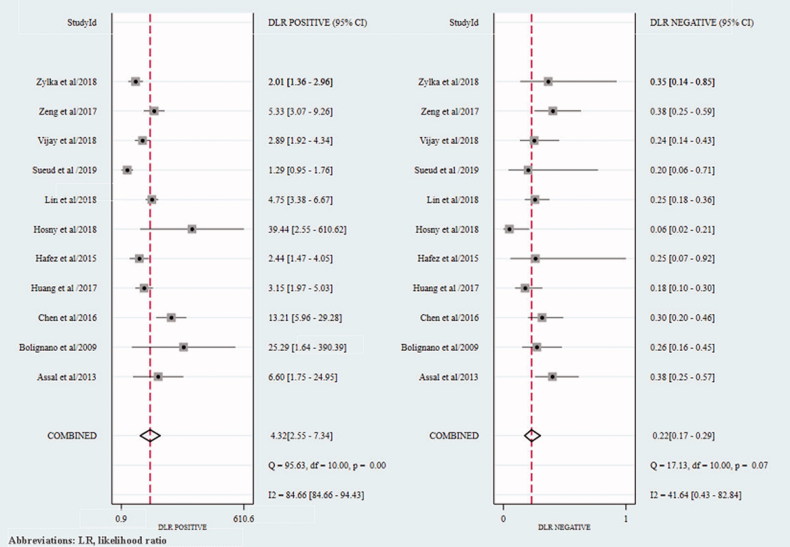
The forest plot of positive LR and negative LR of cross-sectional studies. LR: likelihood ratio.